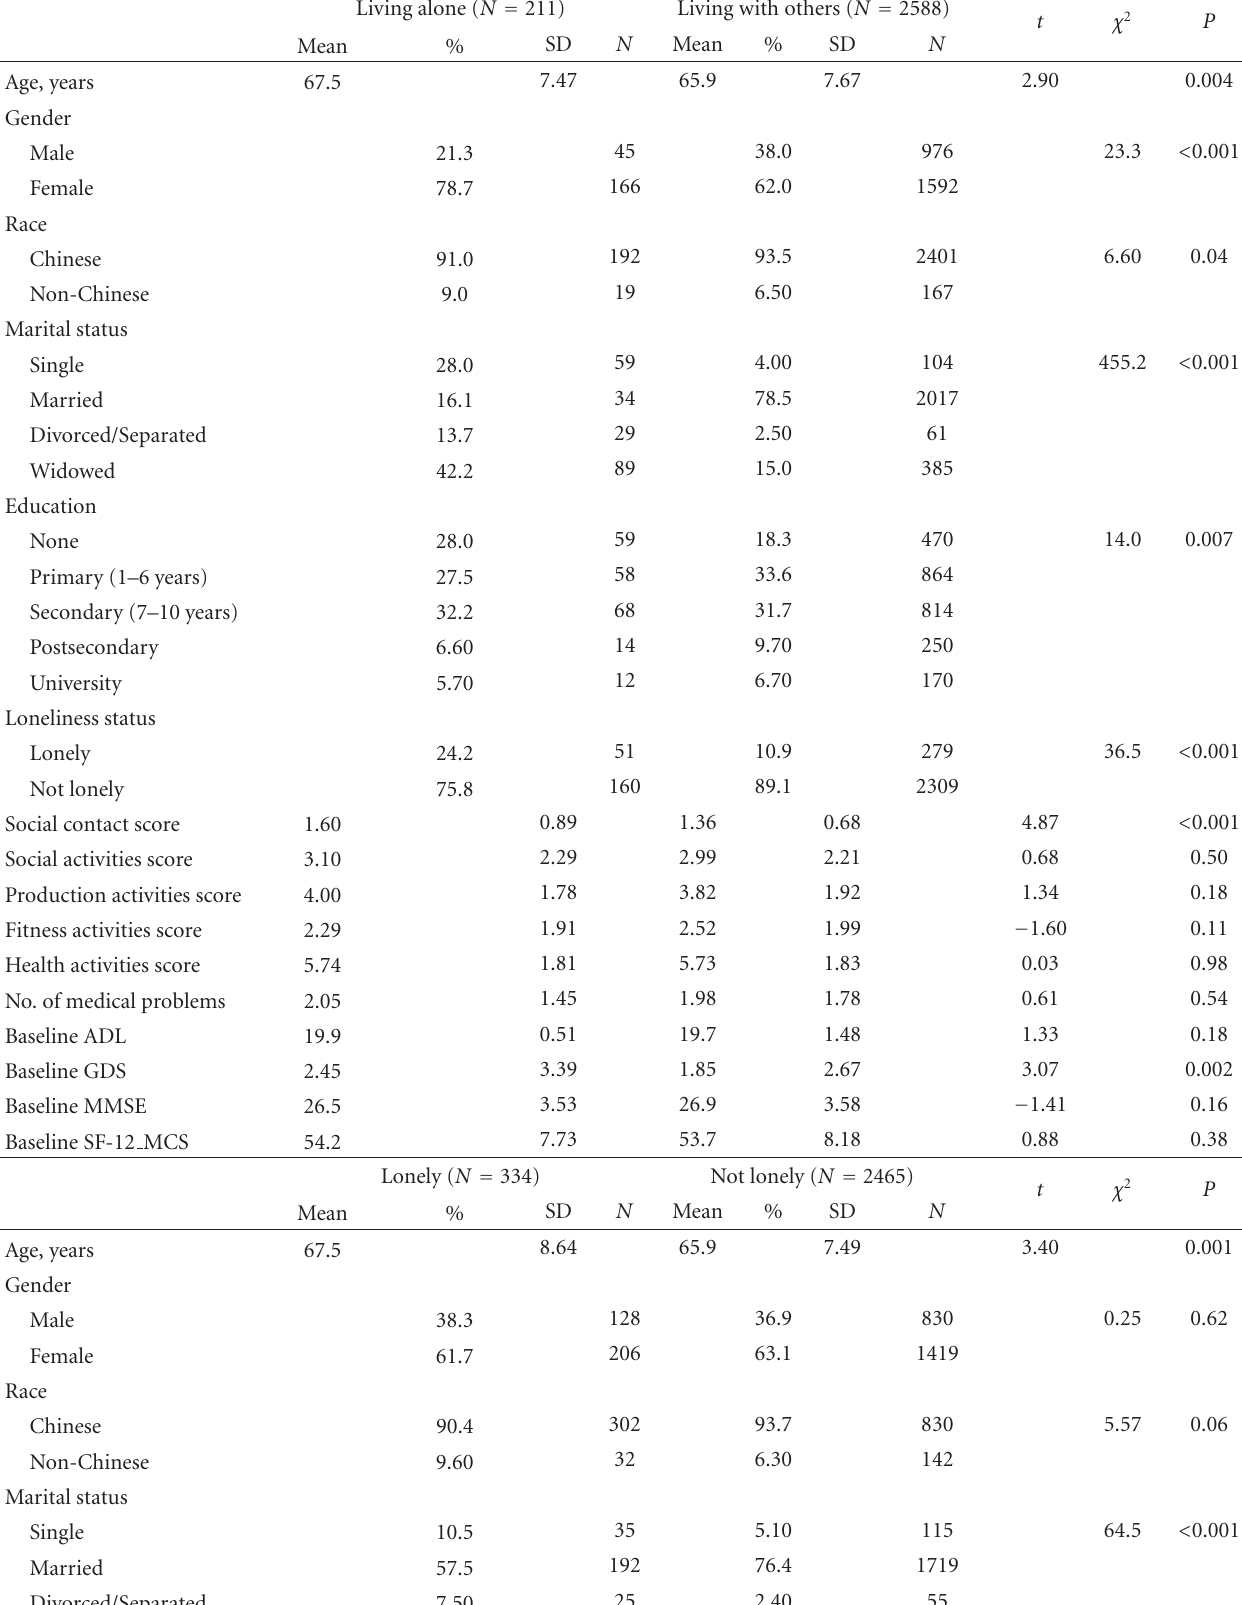
Table 1: Baseline characteristics and well-being of older adults by living arrangement ( N = 2799). Living alone ( N =